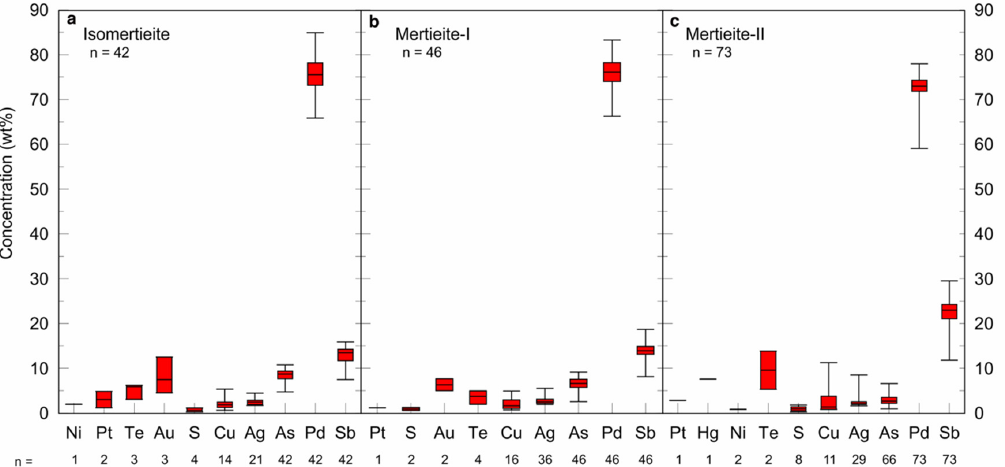
Figure 11. Multi-element box and whisker plots showing elemental variation (in wt%) in the composition of ( a ) isomertieite, ( b ) mertieite-I, and ( c ) mertieite-II grains recovered from tills. Whiskers represent the range of minimum and maximum values. The short line within each box represents the median value, which separates the box into two parts (i.e., lower 25th–50th percentile group and upper 50th–75th percentile). The n below the axis: number of grains containing the element of